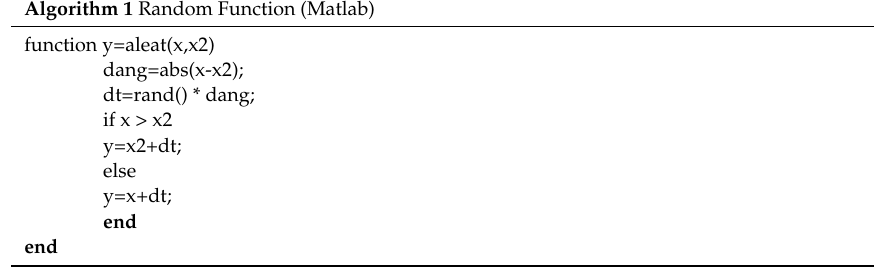
Algorithm 1 Random Function (Matlab)